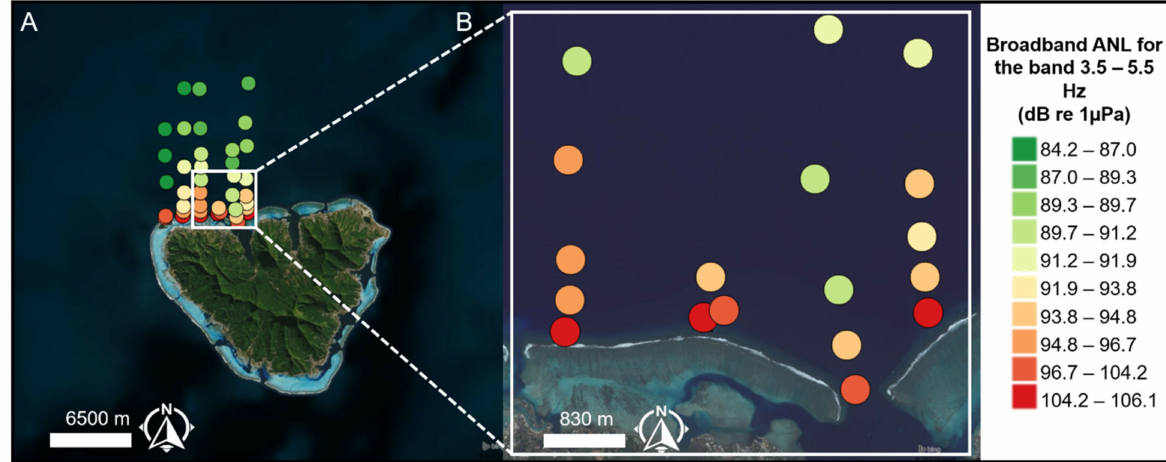
Figure 1. ( A ) Distribution of the ambient noise level (ANL) of the benthic transient sounds (BTS) between 3.5 and 5.5 kHz on the 40 stations and ( B ) zoom of the proximal part of the transects. Color scale indicates ambient noise